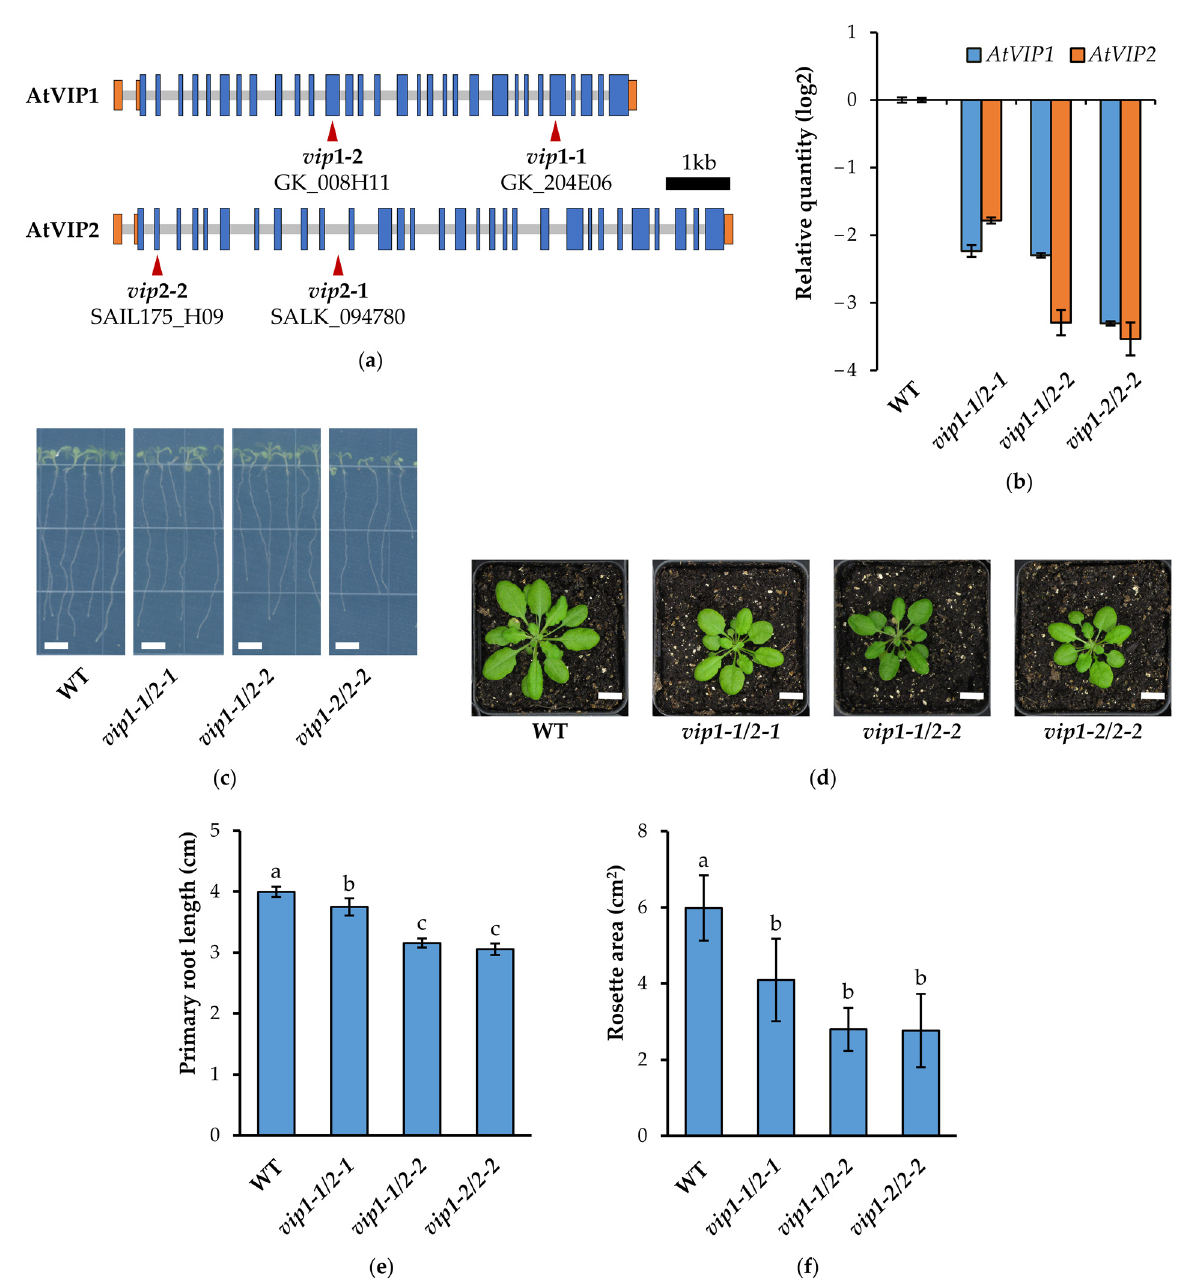
Figure 1. Double vip mutant generation and morphometric analysis. ( a ) Gene structure of Arabidopsis AtVIP1 (AT3G01310) and AtVIP2 (AT5G15070). Exon coding regions are indicated in blue, untranslated regions are indicated in orange, and introns are indicated in gray. The position of the T-DNA insertions are indicated by the red arrows. Three independent homozygous double mutants ( vip1-1 / vip2-1 , vip1-1 / vip2-2 , vip1-2 / vip2-2 ) were generated by crossing. ( b ) AtVIP1 and AtVIP2 transcriptional abundances in 14-day-old seedlings relative to WT. Samples were assayed in triplicate by qRT-PCR using gene-specific primers and PP2A as an endogenous control. Error bars denote SD. ( c ) WT and vip double mutant seedlings were grown on 0.5 × MS media for 10 days (scale bars indicate 0.5 cm). ( d ) Young seedlings were transplanted to soil and grown under short day conditions (8 h light) and rosette area was measured after 28 days (scale bars indicate 1 cm). ( e ) Primary root lengths. Data presented are the average ± SD of two independent experiments ( n = 50/experiment). Different letters indicate statistically significant means (Tukey HSD, α = 0.05). ( f ) Rosette areas. Data presented are the average ± SD of a representative experiment ( n = 12). Different letters indicate statistically significant means (Tukey HSD, α =